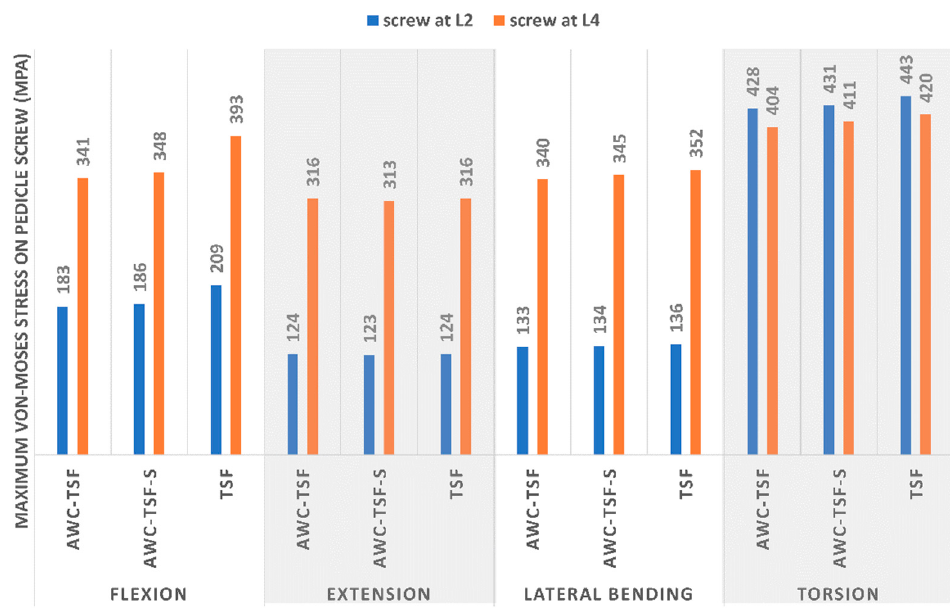
Figure 6. Maximum von Mises stress on pedicle screws at L2 and L4.